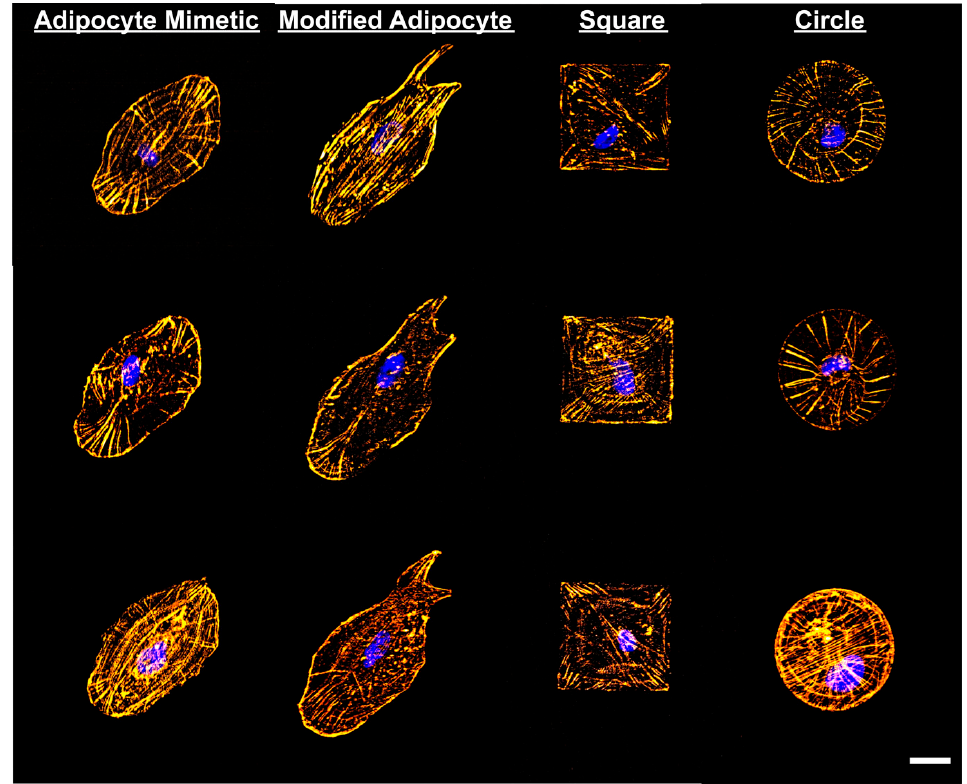
Figure 10. Actin cytoskeleton of human stem cells on adipocyte mimetic fibronectin patterns, modified adipocyte fibronectin patterns as well as square and circle fibronectin patterns. Here gold color stands for F-actin while blue color stands for the nucleus. The scale bar is 25 μ m. Reproduced with permission from ref. [165].